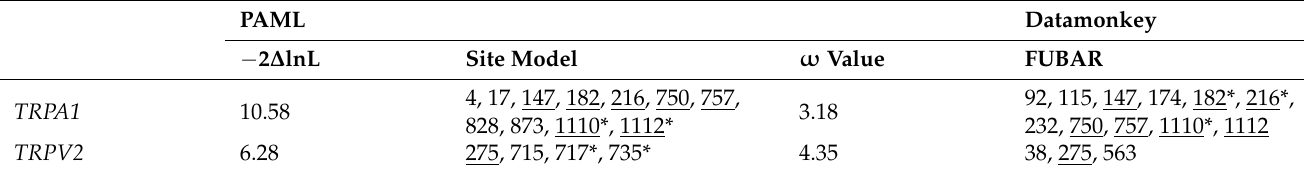
Table 1. Positive selection at amino acid sites of saurian TRP s.